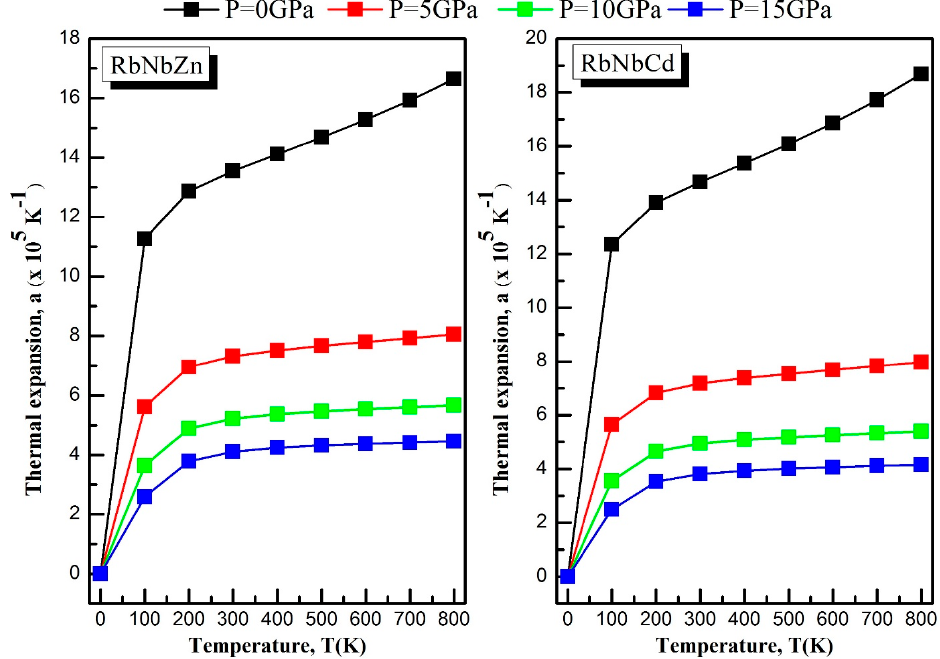
Figure 10. Thermal expansion coefficient ( α ) as a function of temperature at different pressures for RbNbCd and RbNbZn.